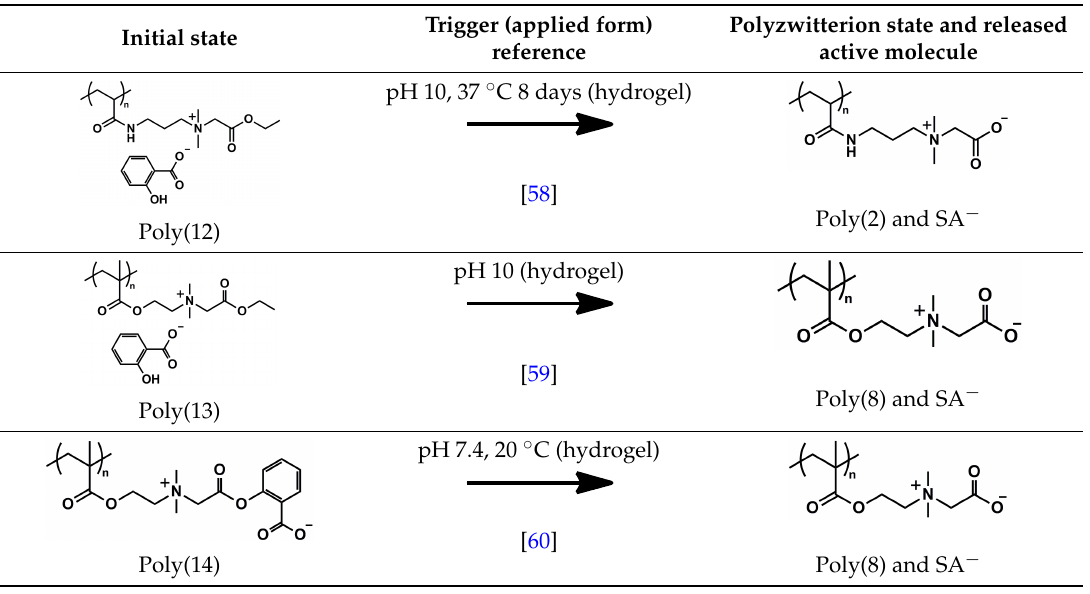
Table 2. Irreversible pH-triggered (meth)acrylic-based switches containing polyzwitterionic state and released active molecule.